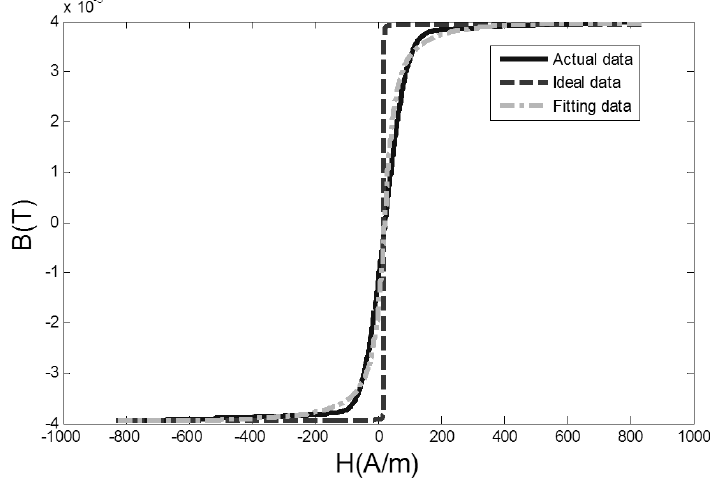
Figure 5. The comparison between actual measuring curve and two fitting curves of the hysteresis